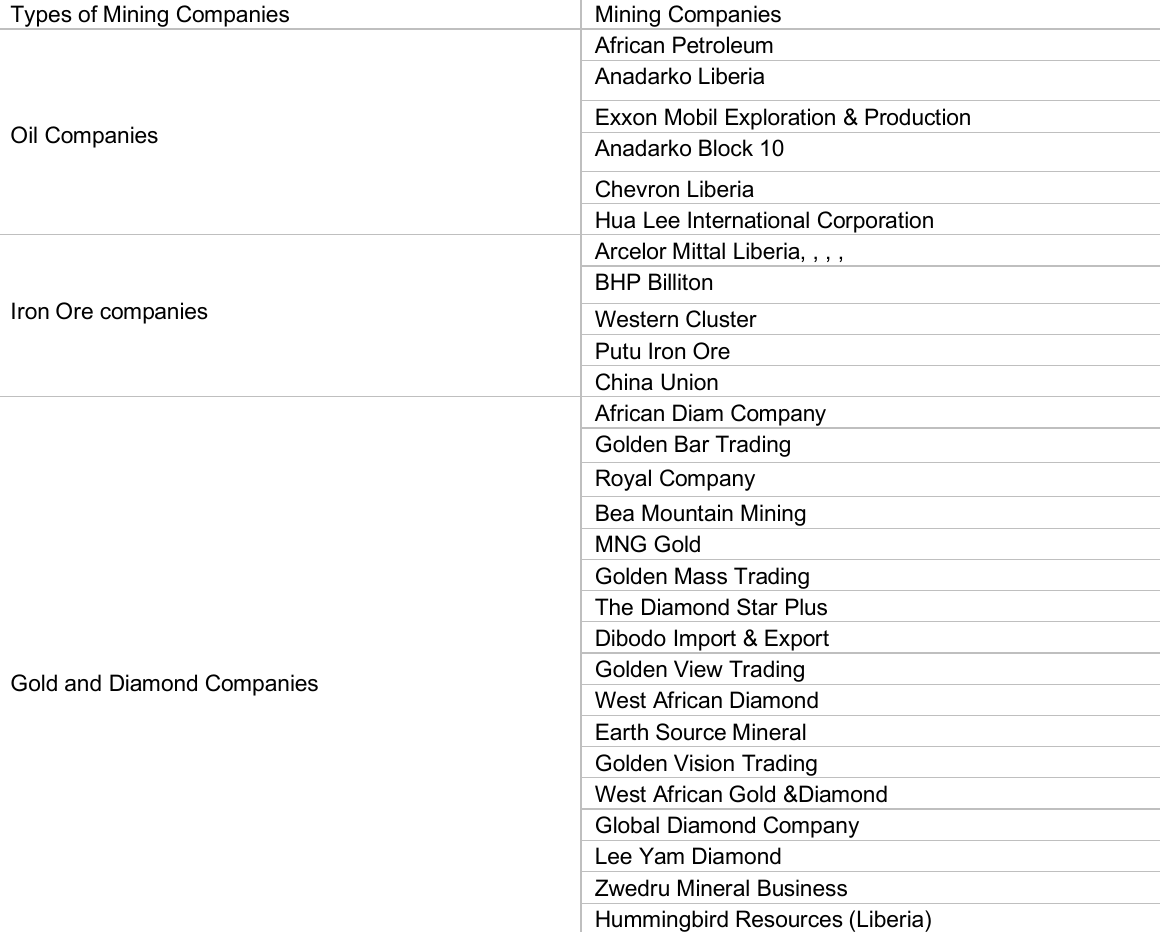
Table 2: Mining Companies in Liberia (LEITI, 2016) Types of Mining